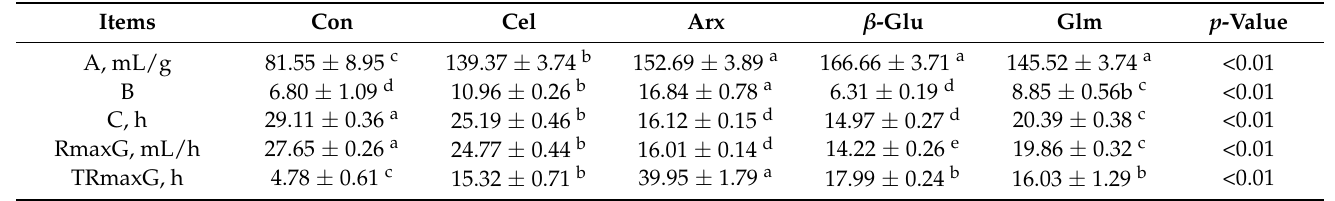
Table 2. The fermentation kinetics of different polysaccharides in cumulative gas production